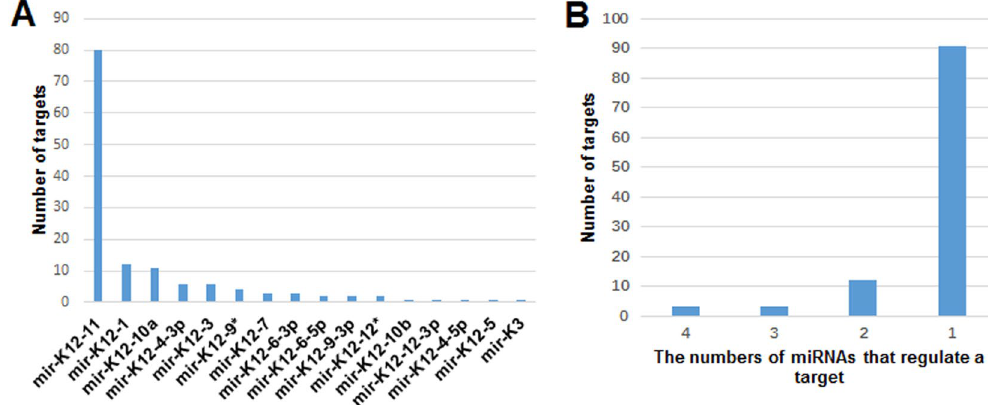
Figure 1. Statistical analysis of KSHV miRNAs and their human targets. ( A ) Number of human targets that each KSHV miRNA regulates. ( B ) Number of targets regulated by different numbers of KSHV